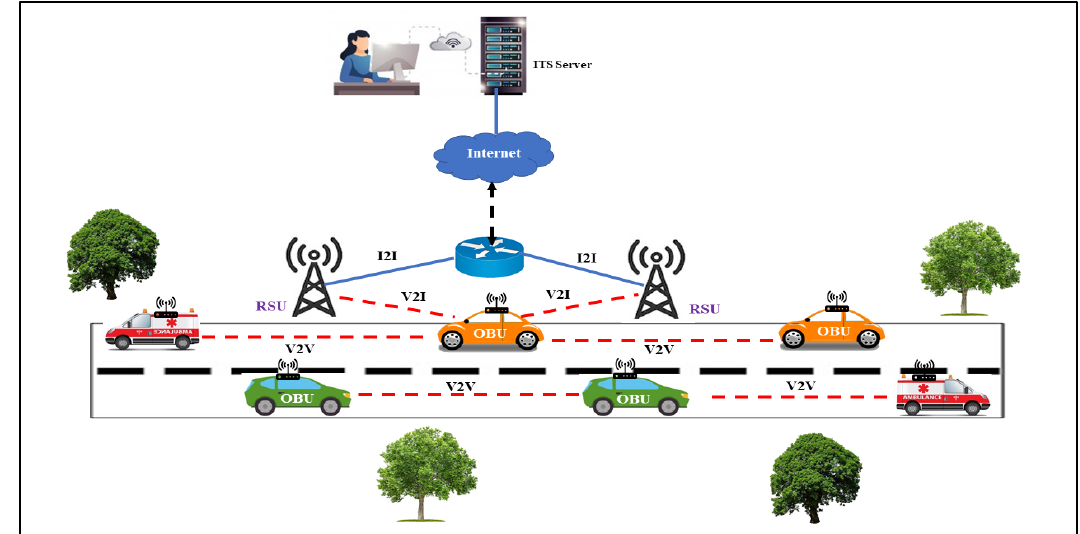
Figure 1. VANET communication